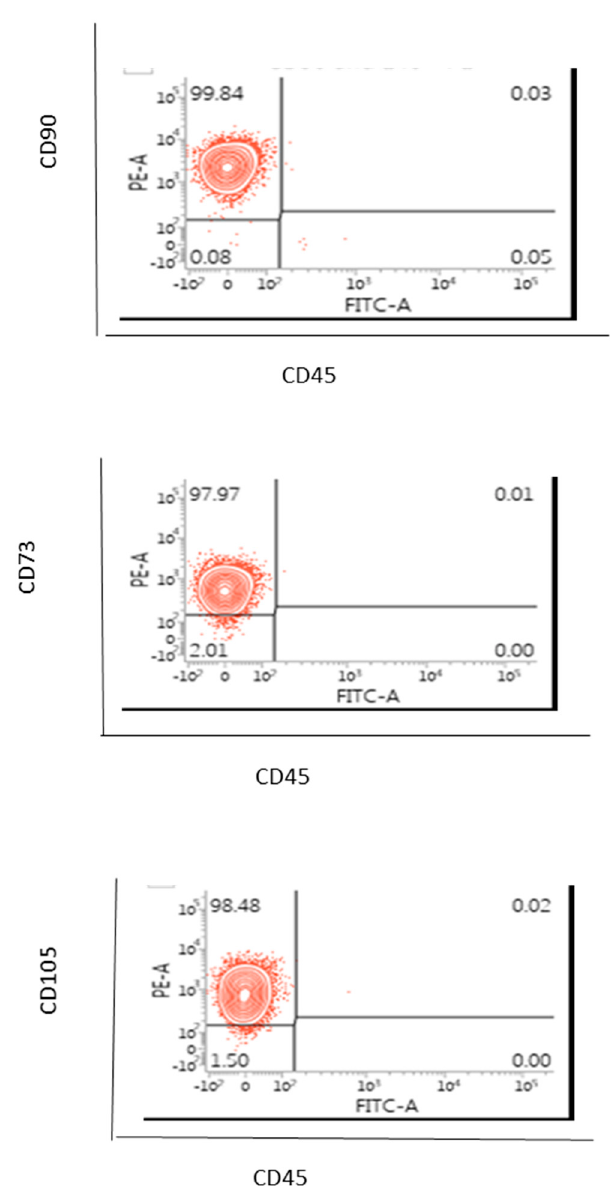
Figure 3. Phenotype of passage 4 of AD-MSCs from patients’ MFAT. Almost all of the cells (>98%) indicated CD90+CD45-, CD73+CD45-, CD105+CD45- showing stem cell/ mesenchymal stem cell (MSC) origin and capacity. One sample only shown here.